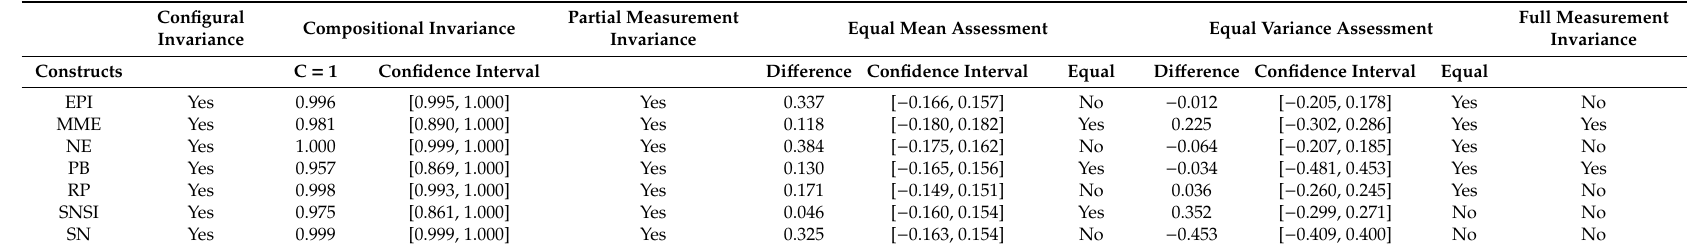
Table 6. Results of invariance measurement